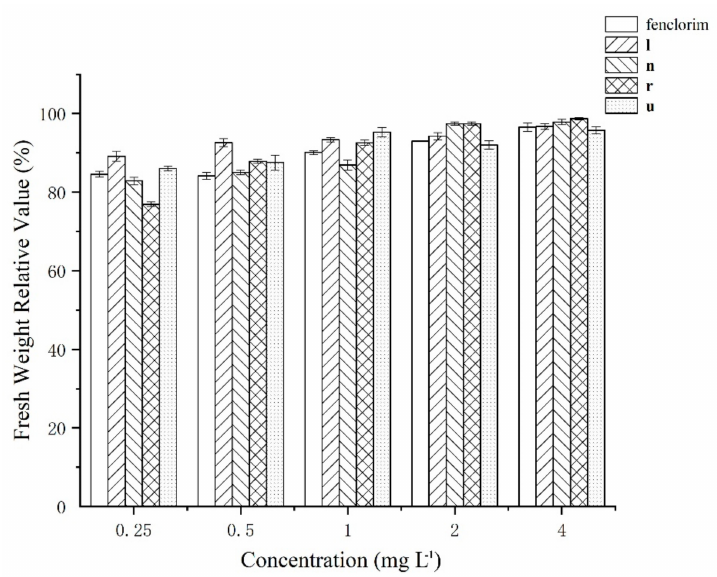
Figure 4. Fresh weight relative value of 0.25 µ M metolachlor ( M )-treated rice seedlings treated with compounds 1 , n , r , and u at 0.25 mg L − 1 , 0.5 mg L − 1 , 1 mg L − 1 , 2 mg L − 1 , and 4 mg L − 1